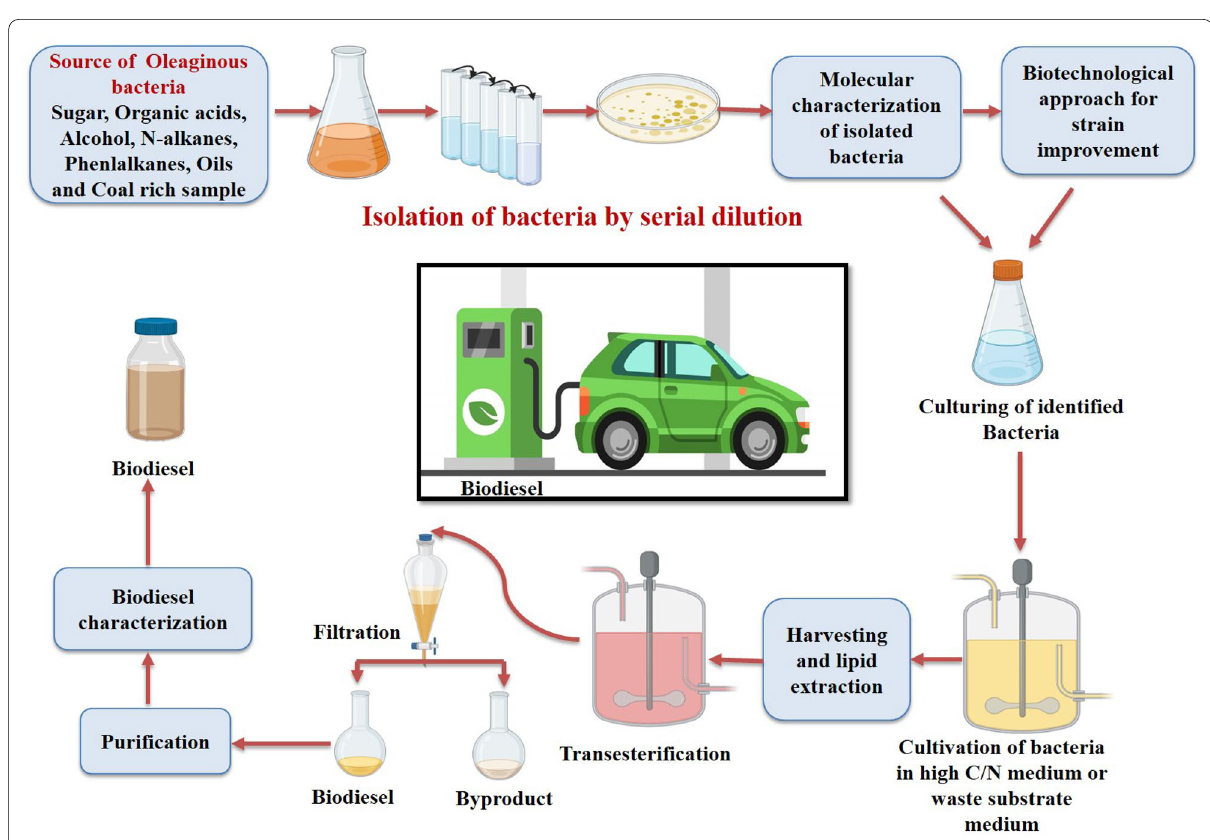
Fig. 1 Flow chart biodiesel production from oleaginous